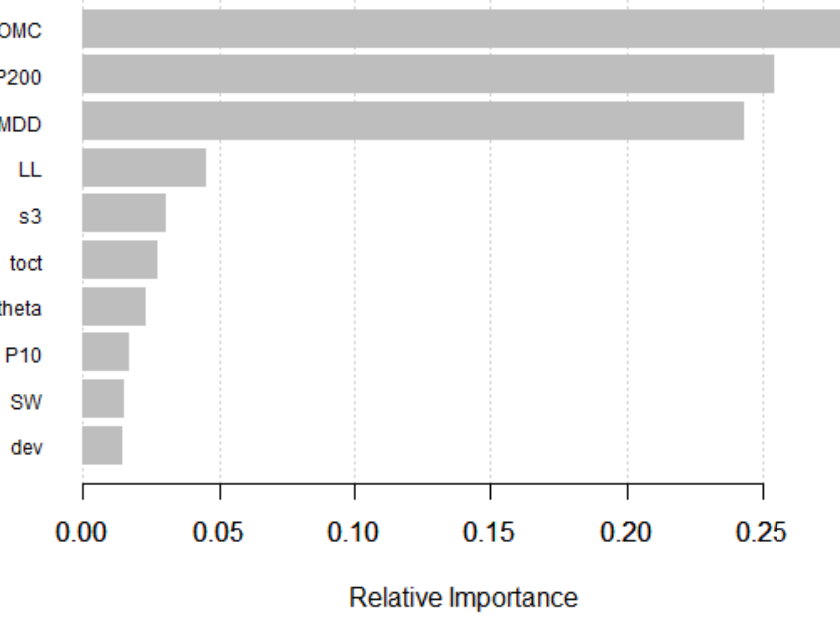
Table 4. Model Estimation Results (MLR Model).